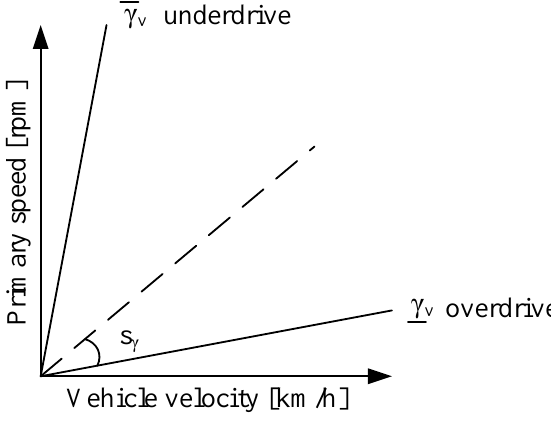
Figure 5. Ratio coverage of the